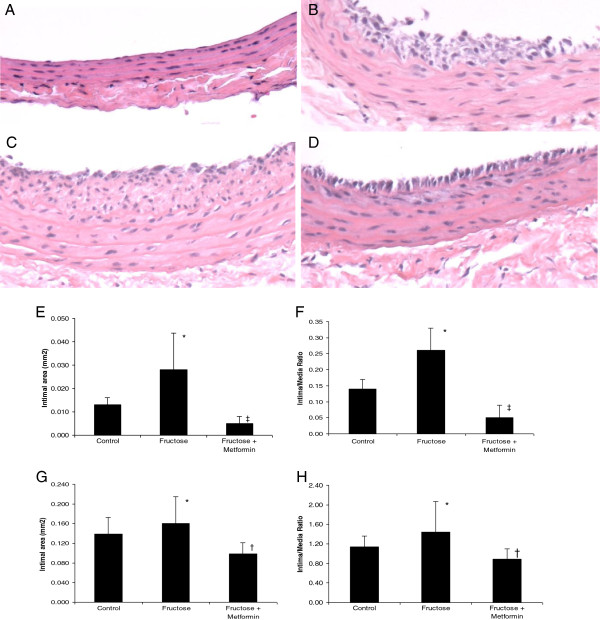
Histological and morphometric changes of balloon injury-induced neointimal formation in insulin resistant rats. A) A representative of the uninjured carotid artery in normal control rats. B) A representative of histological change 4 week after balloon injury, showing neointimal hyperplasia in chow group treated with metformin. C) A representative of histological change of carotid artery 4 weeks after balloon injury, showing severe neointimal hyperplasia in rats with high fructose diet. D) A representative of histologic change 4 weeks after balloon injury in rats with high fructose diet and metformin administration (H&E staining, magnification x 100). Morphometric analyses on intimal area and intima to media ratio were performed to quantitate neointimal hyperplasia at week 1 (E and F) and week 4 (G and H). *P < 0.05 vs. Chow control, †P < 0.05 vs. Fructose group.